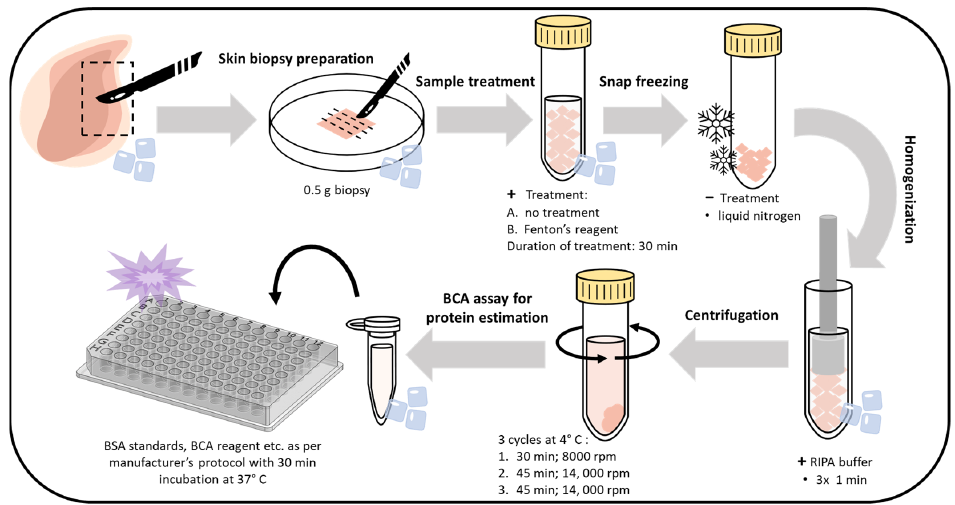
Figure 10. Steps showing the workflow and optimized protocol for whole-skin tissue lysate preparation, isolation, and the BCA assay for protein estimation.